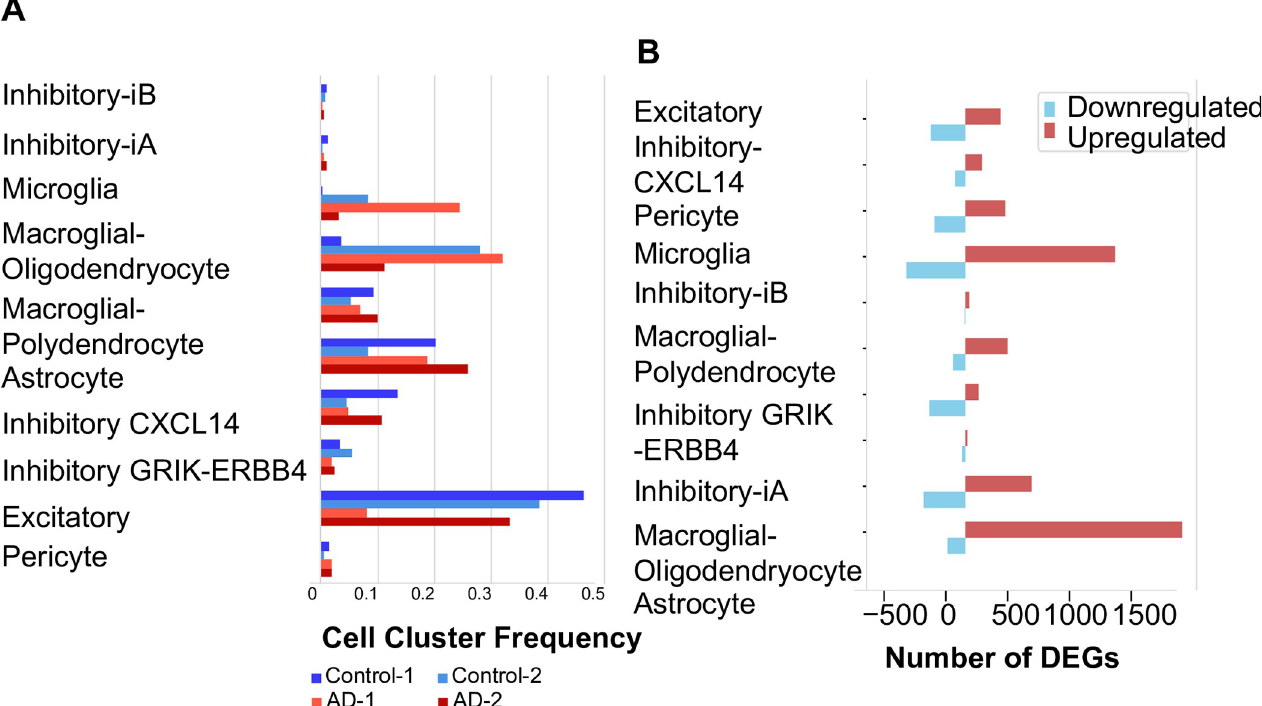
Fig 2. UMAP plots of 6 genes found as differentially expressed. A) UMAP plots 6 genes found as altered in the AD brain samples compared to controls (namely APBB1IP , ST18 , PDGFRA , GRIK3 , SV2B ). B) Hierarchical clustering (HCL) of the 4 AD vs control samples (color bar: Log fold changes, from light blue to yellow). Top line; cell type specific classes, y axis: The clustered differentially expressed gene names. Left: Relevant gene functional categories are noted. Right: Altered gene symbols. Down: Alzheimer’s and control brain